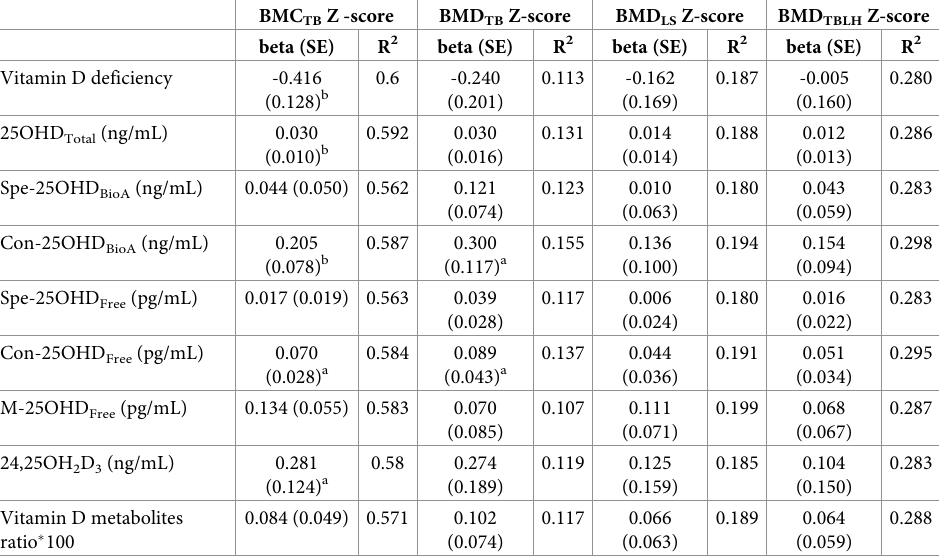
Table 4. Multivariate regression analysis for vitamin D metabolites and bone health parameters in normal weight